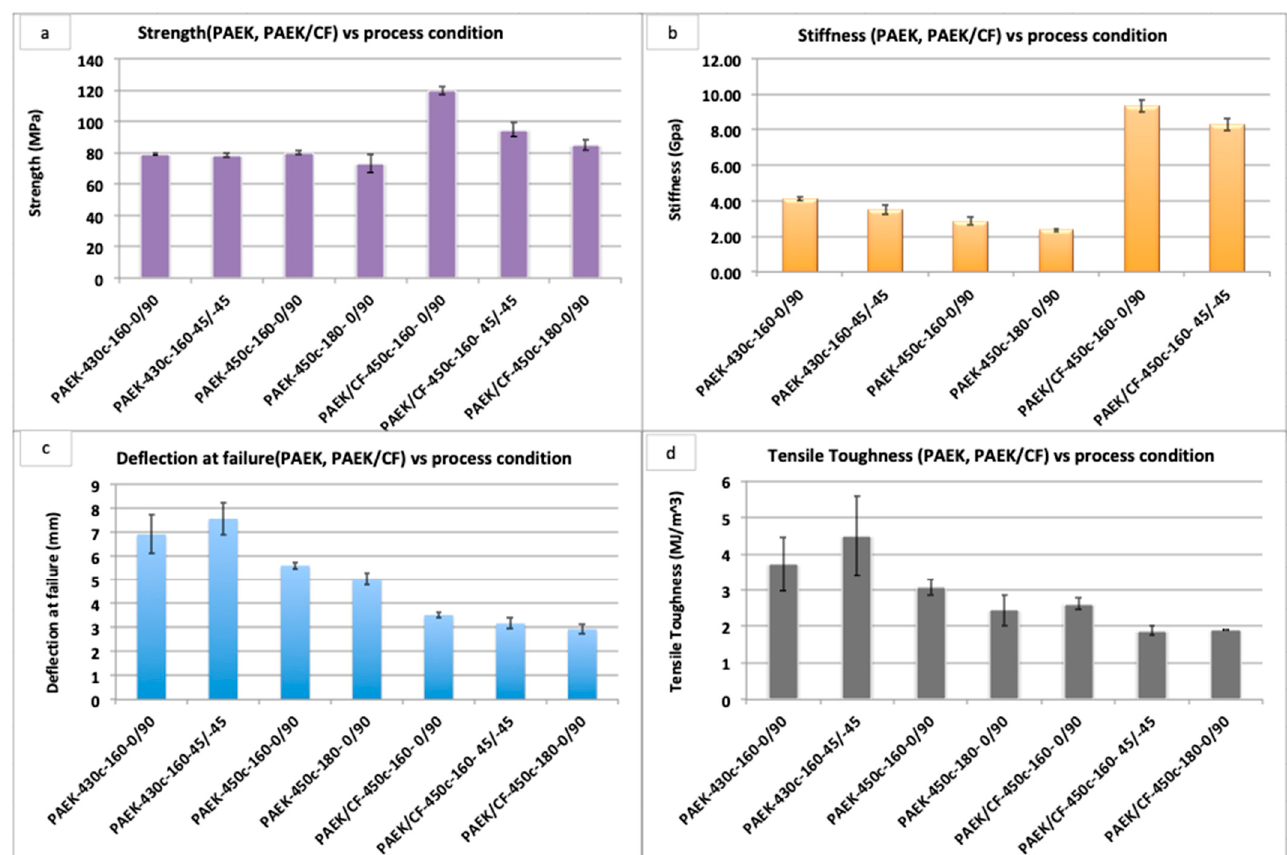
Figure 9. PAEK and PAEK/CF composites’ mechanical properties: ( a ) strength, ( b ) stiffness, ( c ) de- flection at failure, and ( d ) toughness. The X-axis label shows the performance of PAEK or PAEK/CF at nozzle temeparatures(430 °C and 450 °C) and oven temperatures (160 °C & 180 °C) for different raster angles (45/ − 45 &0/90).